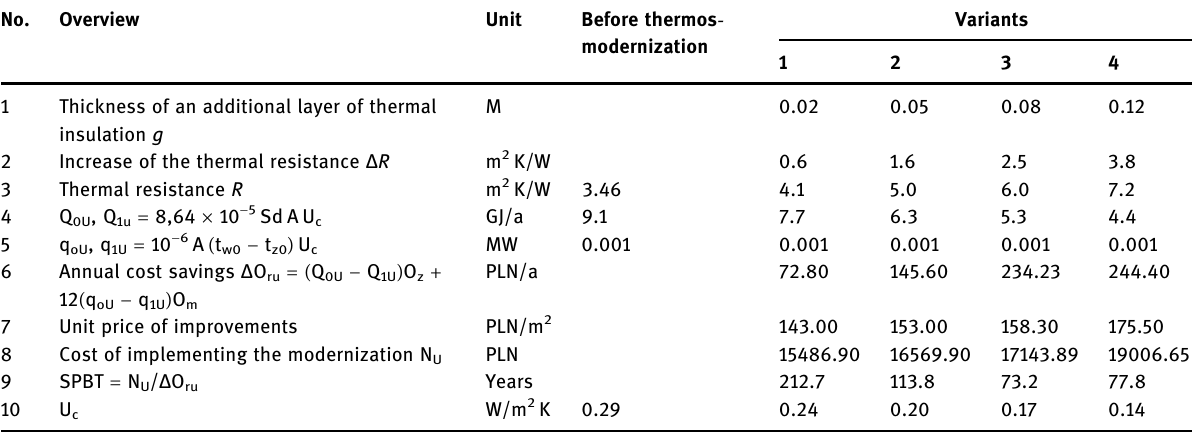
Table 5: Payback time of the isolation of external walls of the building of the ice rink No.